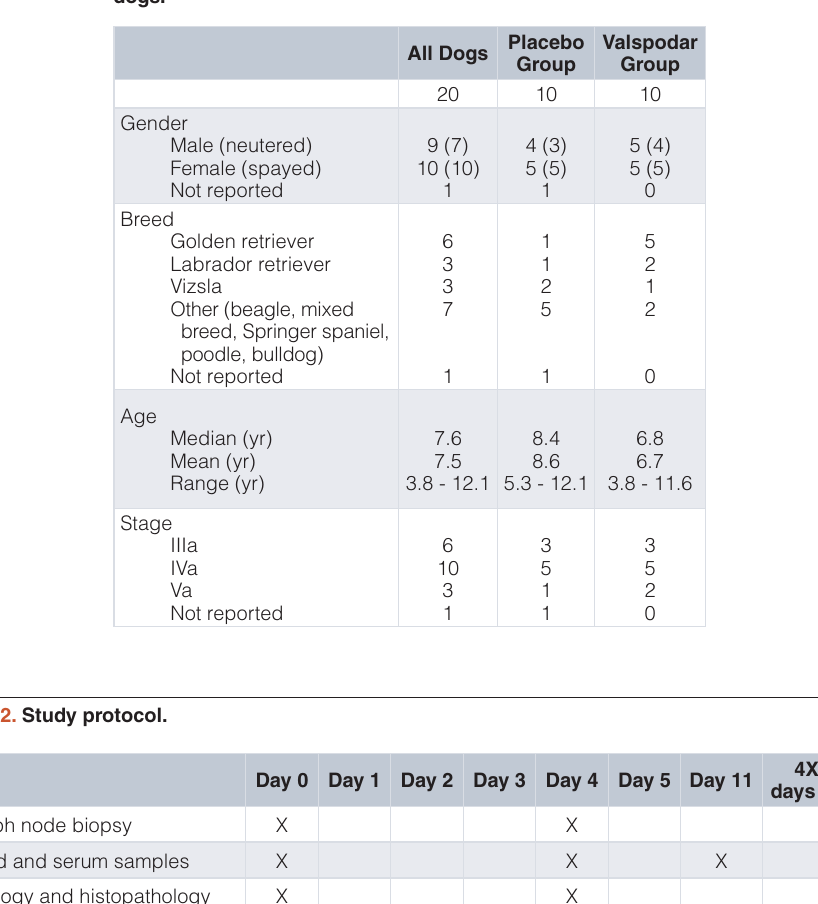
Table 1. Signalment (demographic characteristics) of study dogs.